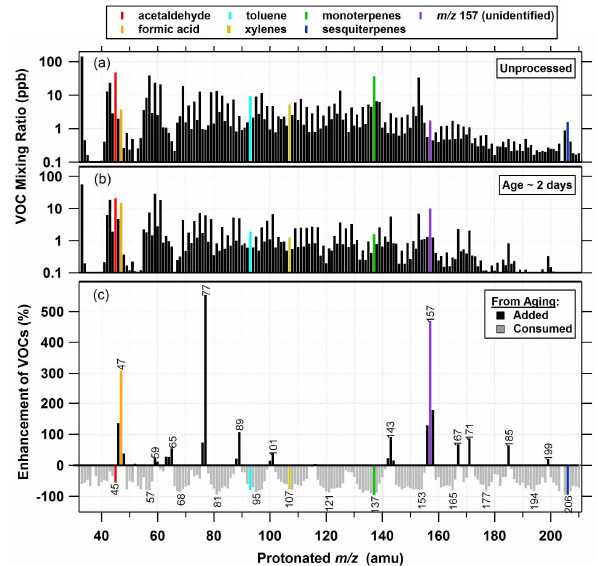
Fig. 3. Time series for select VOCs and oxidants measured af- ter the reactor during burn 55, white spruce. The time series be- gins with lights off in the reactor, then transitions to increasing O 3 concentration (blue, bottom panel) and OH exposures (purple, bottom panel) in steps. The reactor was sampled with lights off (gray), then at OH exp = 5 . 2 × 10 10 molec.cm − 3 s ( ∼ 0.4 days ag- ing, white), OH exp = 1 . 6 × 10 11 molec.cm − 3 s ( ∼ 1.25 days aging, light yellow), and OH exp = 2 . 6 × 10 11 molec. cm − 3 s ( ∼ 2 days aging, bright yellow). Diamond markers indicate where the mass spectra presented in Fig. 4 were taken.